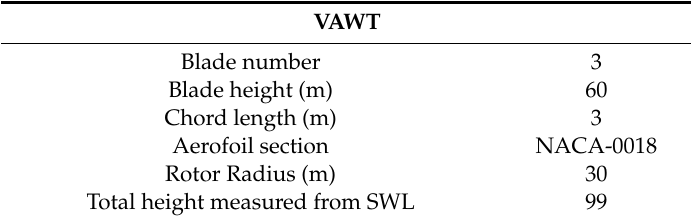
Table 2. Main parameters of the wind–solar power generation system. VAWT—vertical-axis wind turbine; SWL—still water level.